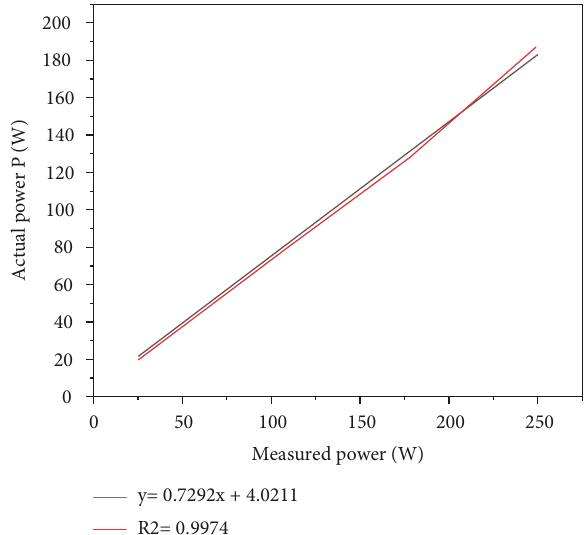
Figure 3: The relationship between the time power P and the measured power p at a speed of 50rpm. 0